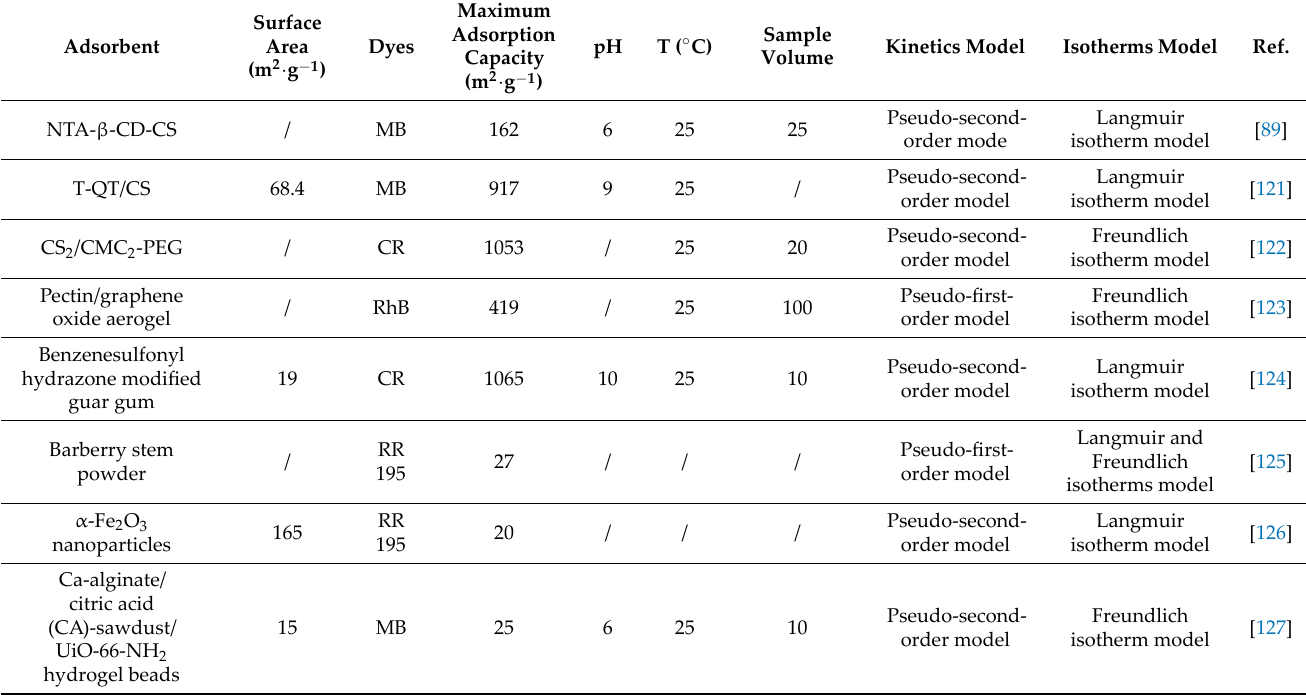
Table 4. The adsorption performance of other adsorbents for